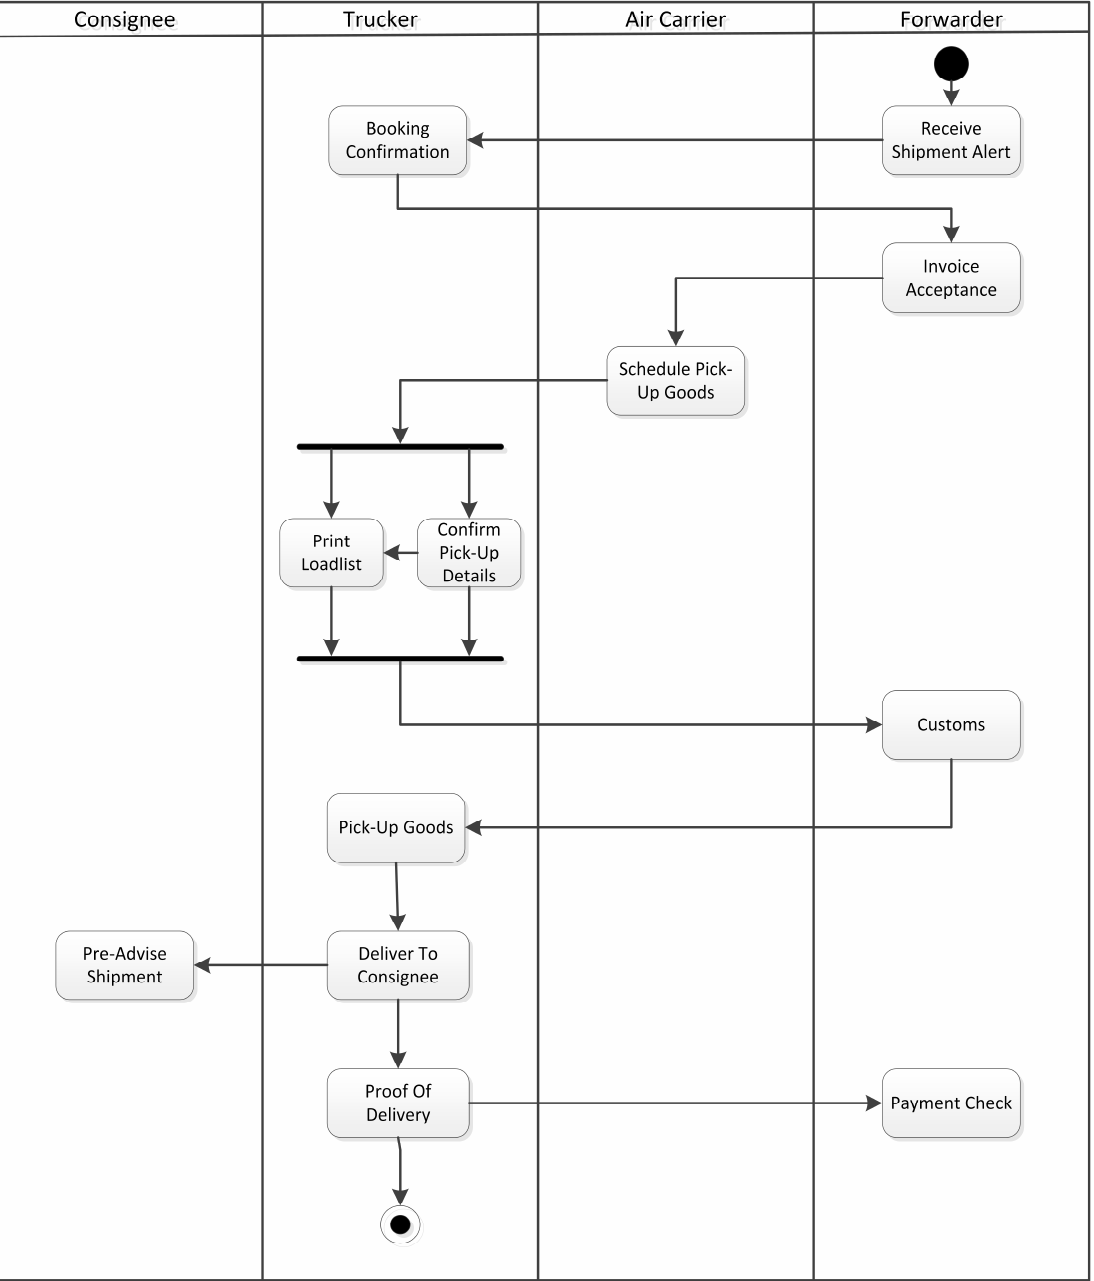
Figure 3. Activity diagram of the transportation use case example.